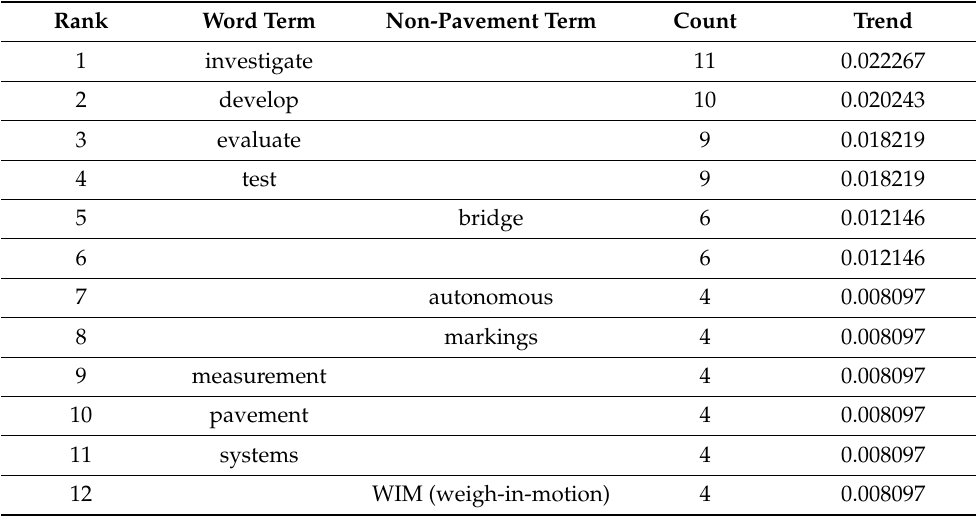
Table 2. Terms used more than four times in the text and their relative